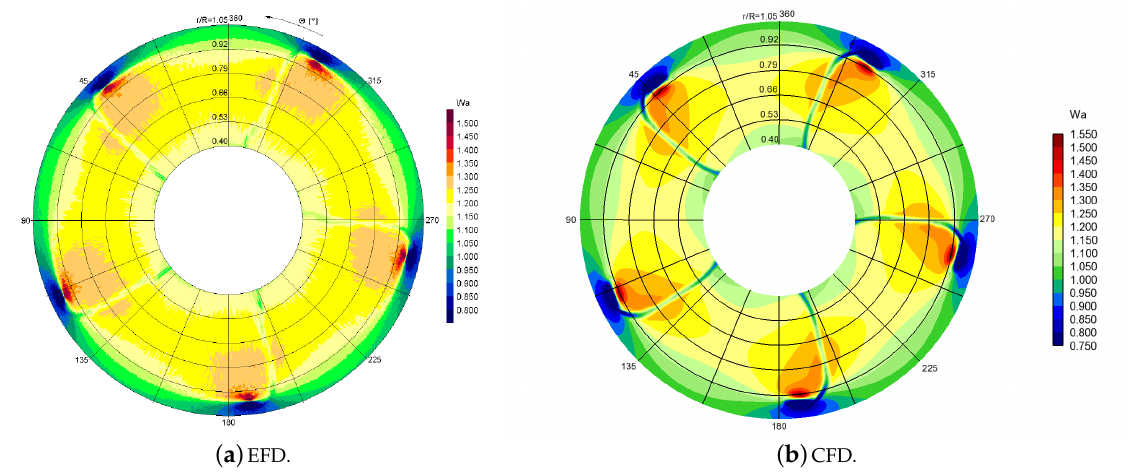
Figure 11. Comparison of axial wake distributions at x / D = 0.20 behind the propeller.